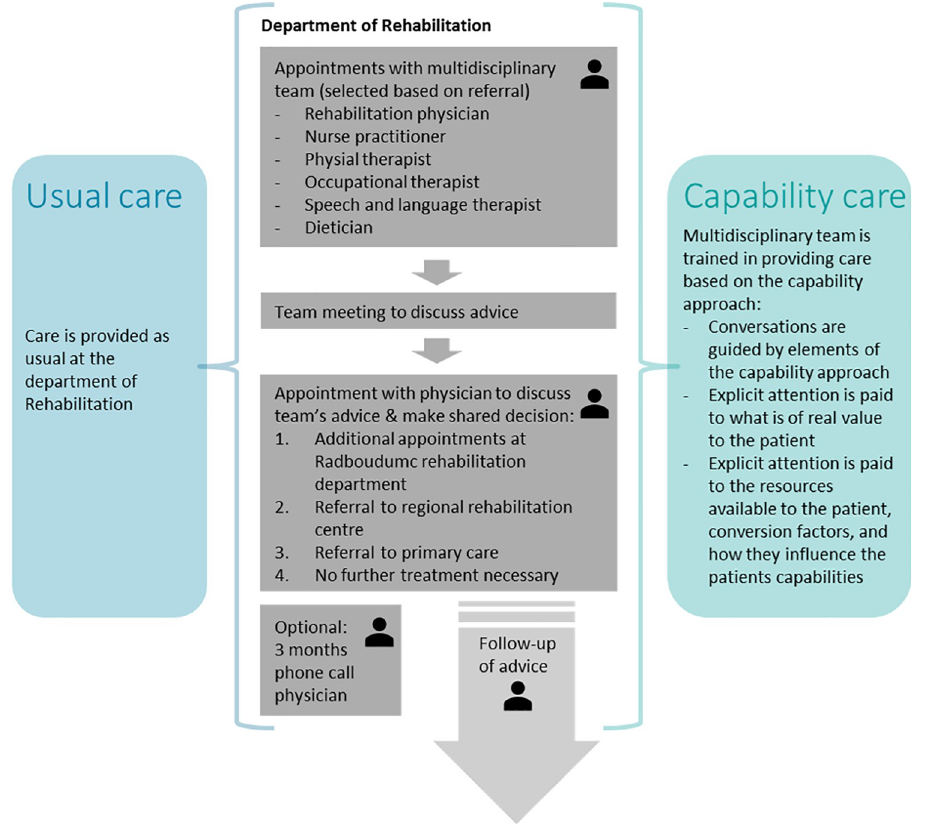
Fig 5. Flowchart of usual care and capability care pathway for the patient. The patient is visualised with the icon of a person, which shows the patient journey where the patient is present during the consultations. The patient is not present during the team